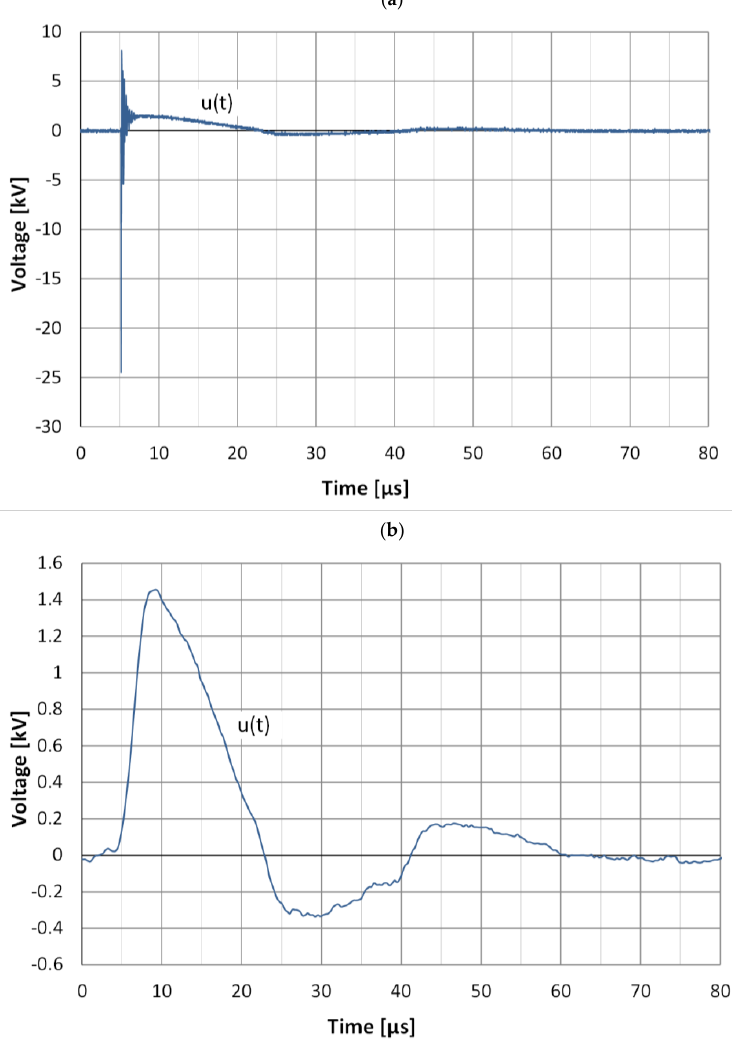
Figure 7. Voltage waveform formed when impulse current flowed through the sample, measured along OY axis between the HV electrode and one of the sample edges: ( a ) raw data; ( b ) processed data.